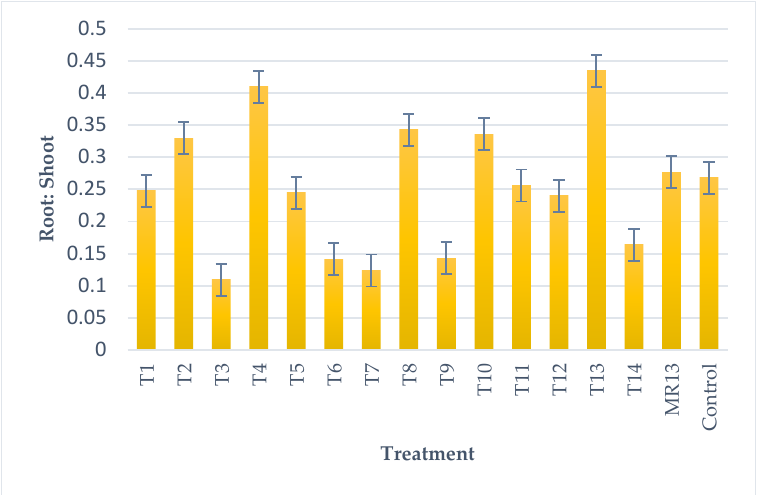
Figure 5. The root to shoot ratio of chilli seedlings treated with endophytic bacteria and moringa leaf extract using various extraction methods. The values are an average of five independent meas- urements.